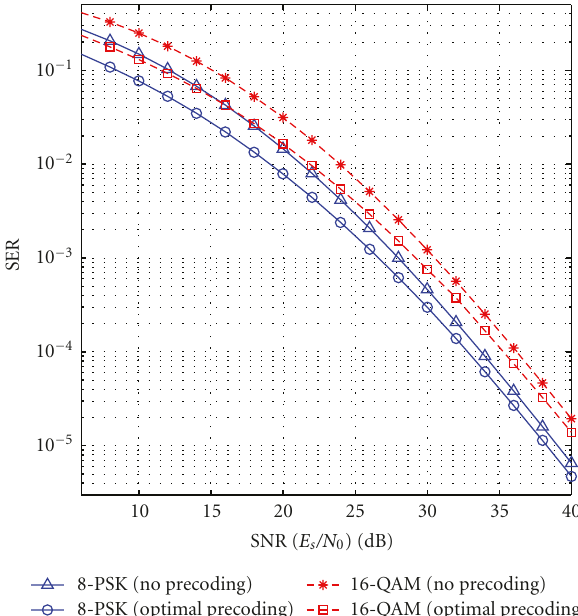
Figure 6: Performance improvements achieved with optimal precoding in a 4 × 4 MIMO system based on OSTBC G 4 from [21]. The transmit antenna correlation follows the exponential model while the receive antenna correlation is modeled by a general complex correlation matrix from